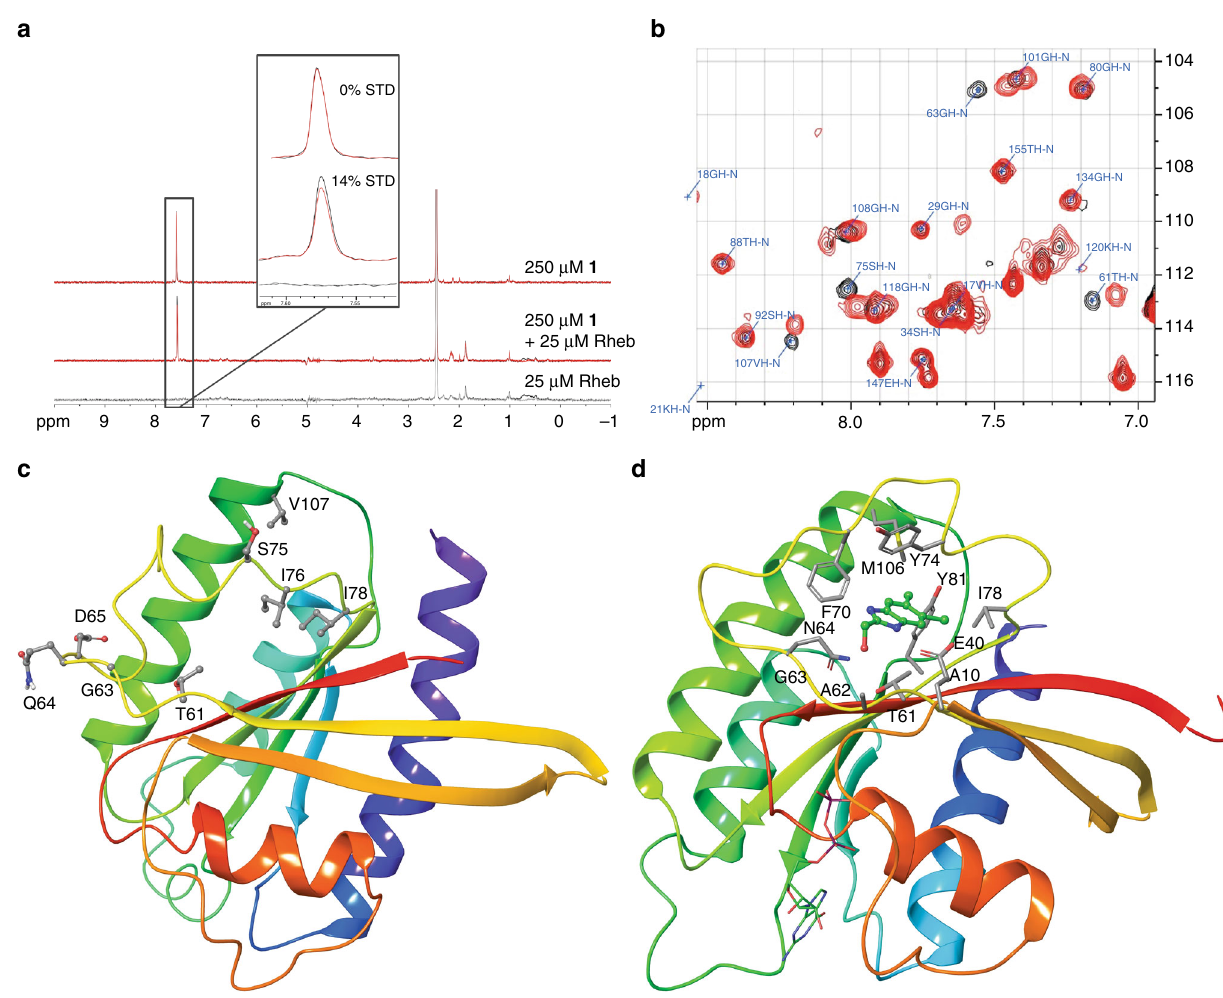
Fig. 1 Fragment-based lead generation of Rheb-binding small molecules. a 1D 1 H saturation transfer difference (STD) NMR spectra of 1 in presence and absence of C-terminal truncated Rheb. b 2D 1 H – 15 N heteronuclear multi-quantum coherence (HMQC) NMR spectra of 15 N-labeled Rheb (200 µ M) alone (black) and in presence of 1 mM 1 (red) showing key residues of the switch II domain. c Structure of Rheb showing side-chains of residues where signi fi cant chemical shift perturbations were observed upon binding 1 . NMR structure of GDP-bound Rheb from Karassek et al. 37 shown. d 1.56 Å X-ray crystal structure of GDP-Rheb with 1 bound in the switch II domain. Side-chains of residues within 4 Å of 1 are